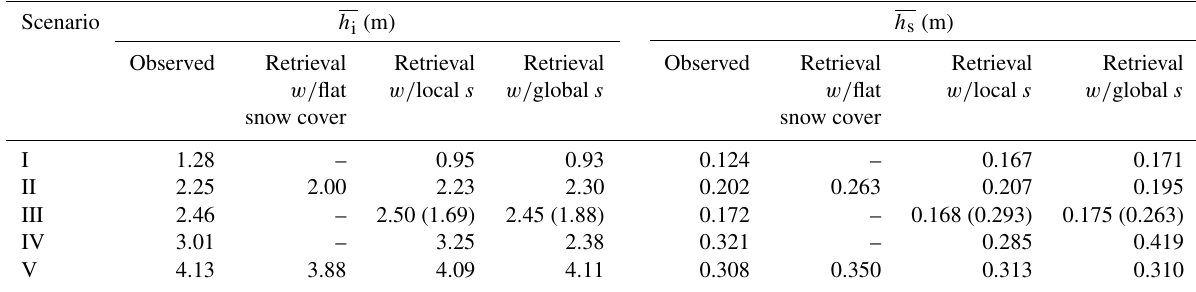
Table 2. Retrieved results ( h i and h s , in units of meters) for five scenarios under different retrieval algorithms. In scenarios II, IV and V, the retrieval with flat snow cover assumption is unsuccessful. The values in the brackets for scenario V denote the other (possible) solution for sea ice